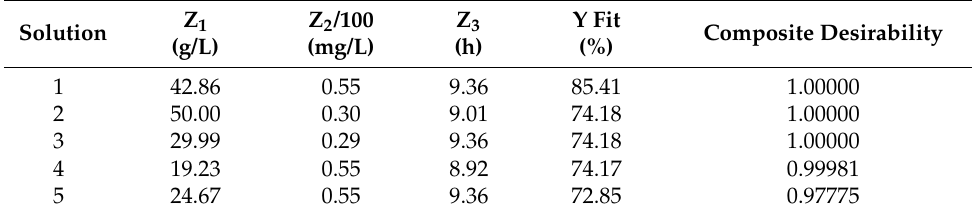
Figure 5. Surface plot ( left ) and contour plot ( right )—efficiency (Y) vs. BRed dye concentration (Z 2 )